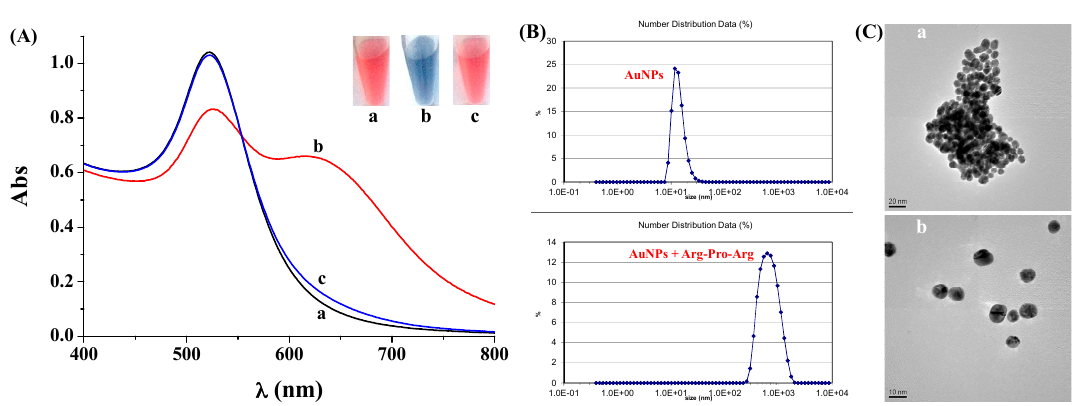
Figure 1. ( A ) UV–vis absorption spectra and photographic images of AuNPs in various systems (curve/tube a, AuNPs; curve/tube b, AuNPs + tripeptide; curve/tube c, AuNPs + tripeptide/DPP-IV). The final concentrations of AuNPs, tripeptide and DPP-IV were 3.6 nM, 5 μ M and 250 mU/mL, respectively; ( B ) dynamic light scattering (DLS) of AuNPs in the absence and presence of tripeptide Arg-Pro-Arg; ( C ) TEM images of AuNPs in the presence of tripeptide (panel a) and tripeptide/DPP-IV (panel b).